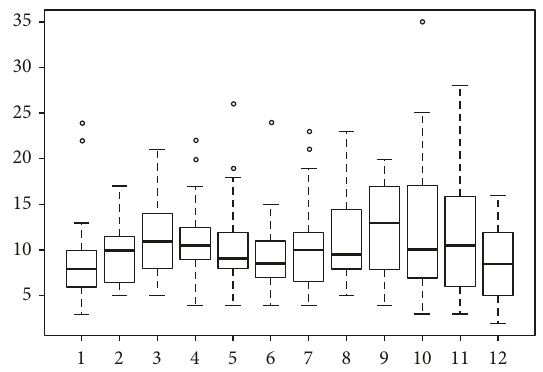
Figure 4: Annual variation of monthly S&P 500